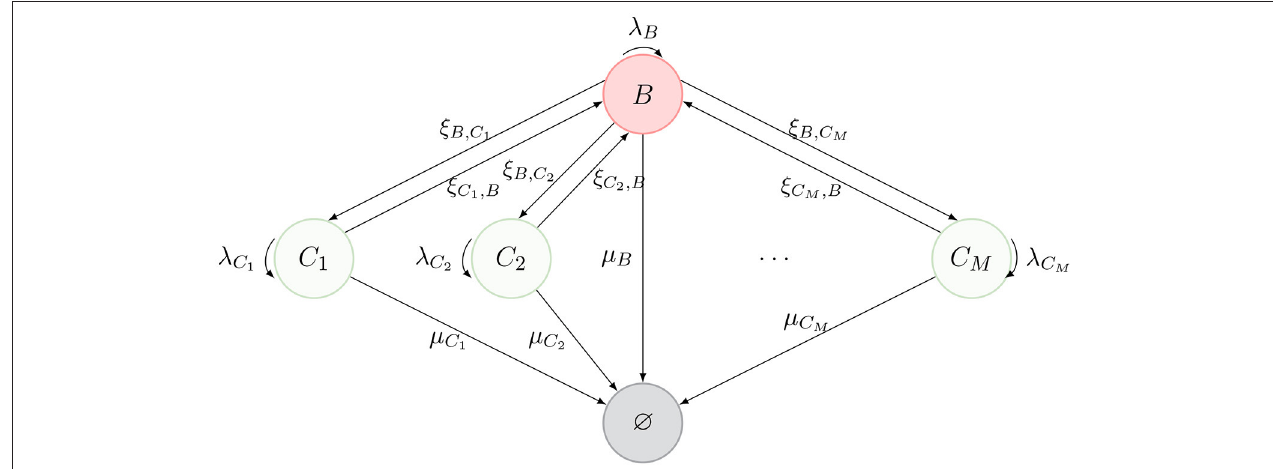
FIGURE 1 | Schematic description of the model. The nodes represent spatial compartments where the CD4 + T cell can be located at a given time. The arrows connecting them represent the migration of the cell between compartments, with migration rates { ( ξ B , C , j ∈ { 1, ... , M }} . Finally, the state ∅ represents the death of the cell (with different death rates µ B and { µ C curved arrows with rates λ B and { λ C j depending on the location where cell death takes